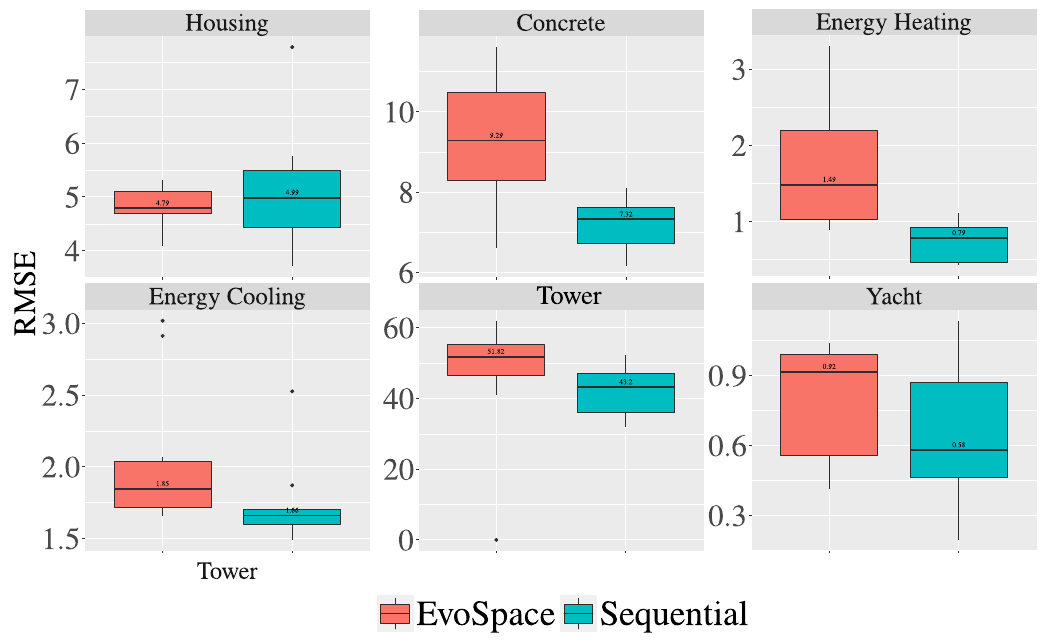
Figure 8. Box plot comparison of the sequential and the EvoSpace implementation of the neat-GP-LS algorithm on the testing RMSE.